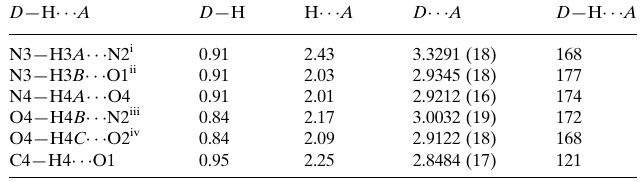
Bruker SMART APEX CCD diffractometer Absorption correction: multi-scan ( SADABS ; Bruker, 2013)